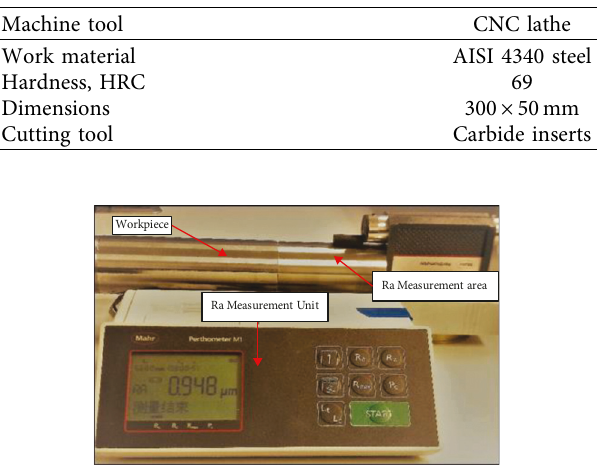
Table 2: Summary of experimental conditions.